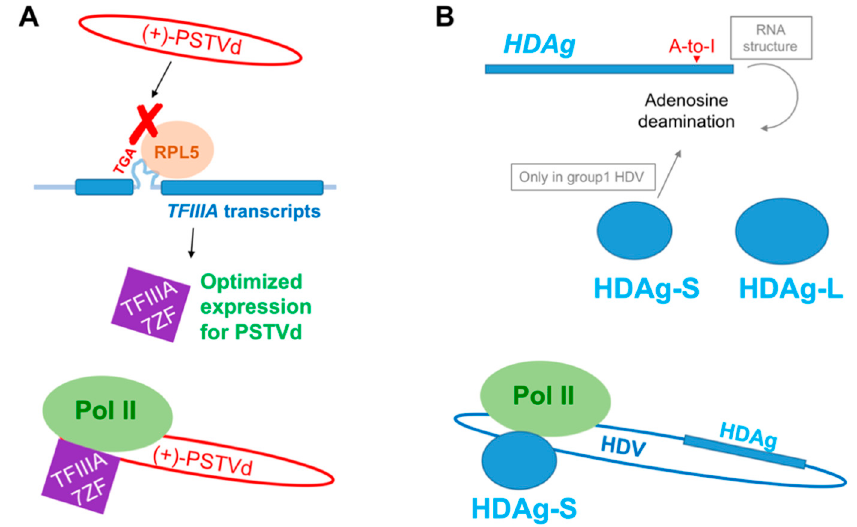
Figure 5. Possible regulatory mechanisms for the expression of TFIIIA-7ZF and HDAg-S. ( A ) PSTVd directly binds to RPL5 to regulate alternative splicing of TFIIIA , resulting in optimized TFIIIA-7ZF expression and PSTVd replication; ( B ) The expression of HDAg-S and HDAg-L is regulated through A-to-I RNA editing at a specific site. Hepatitis delta virus (HDV) RNA structure may affect the editing. In addition, HDAg-S itself may also impact the editing efficiency in group 1 HDV.